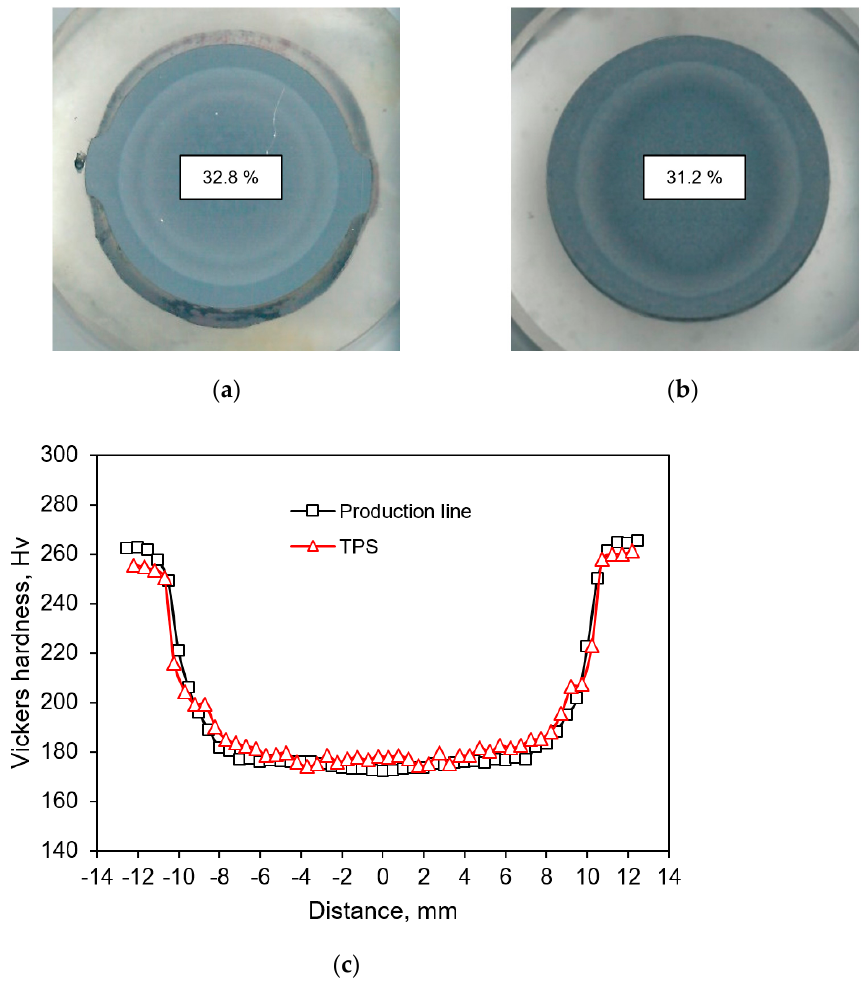
Figure 9. Tempered martensite rims produced by ( a ) shop floor operation; ( b ) TPS; ( c ) variation of microhardness for shop floor operation and TPS.